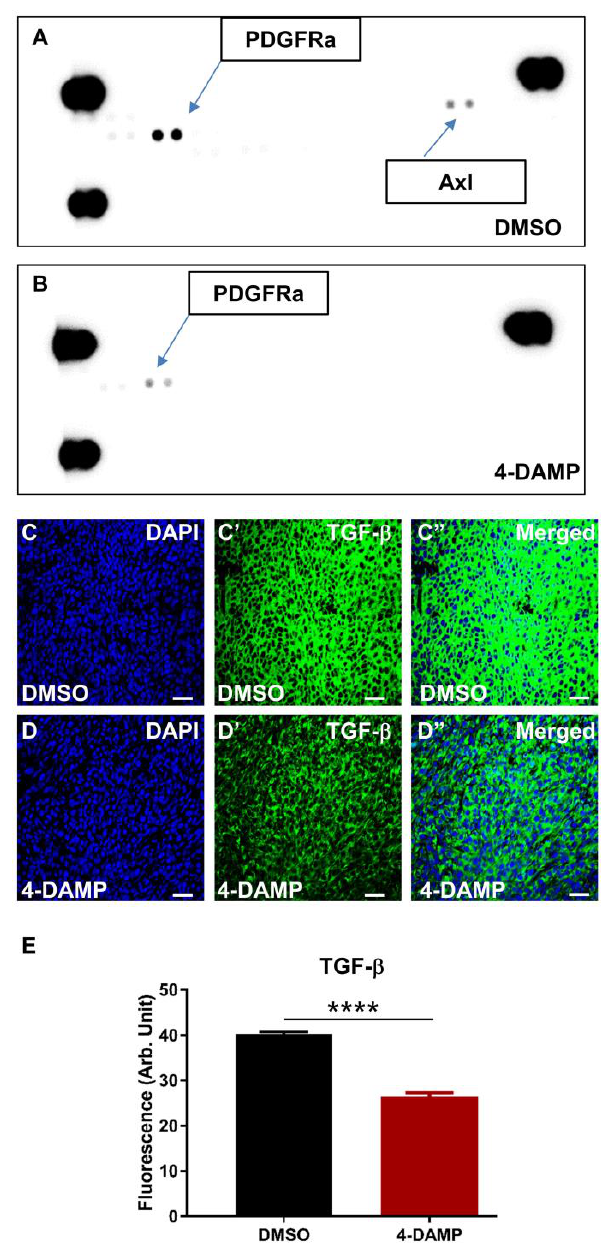
Figure 9. Effect of 4-DAMP treatment on the expression of phosphokinases in vivo. Mouse Phospho- RTK Array measuring phospho-RTK activity in tumors from mice with CT-26-induced CRC treated with DMSO ( A ) and 4-DAMP ( B ). TGF- β in tumor samples from mice bearing CT-26 cell-induced tumors treated with DMSO ( C – C’’ ) and 4-DAMP ( D – D’’ ). Tumors were labeled with the nuclei marker DAPI (blue; C , D ), TGF- β (green; C’ , D’ ), and all markers merged ( C’’ , D’’ ). The scale bar represents 50 µ m. Bar graphs displaying the mean fluorescence level of TGF- β ( E ) in tumor samples from DMSO-treated and 4-DAMP-treated mice. Data presented as mean ± SEM, n = 8 per group. Student’s t- test , **** p < 0.0001.